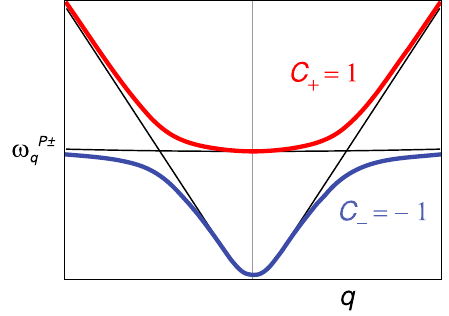
FIG. 2. Schematic polariton spectrum ω P (cid:3) . The upper and q lower polariton bands are drawn in red and blue, while the ¼ 0 ) are shown as thin black lines for uncoupled bands ( g q comparison. Because of the winding structure of the coupling, the two polariton bands acquire a nontrivial topology with finite Chern numbers C (cid:3) ¼ (cid:3) 1 in the case of m ¼ 1 [see Eq. (2)]. The associated edge modes are indicated by a dashed purple